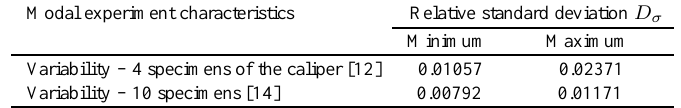
Table 5 Comparison of values of relative standard deviation of